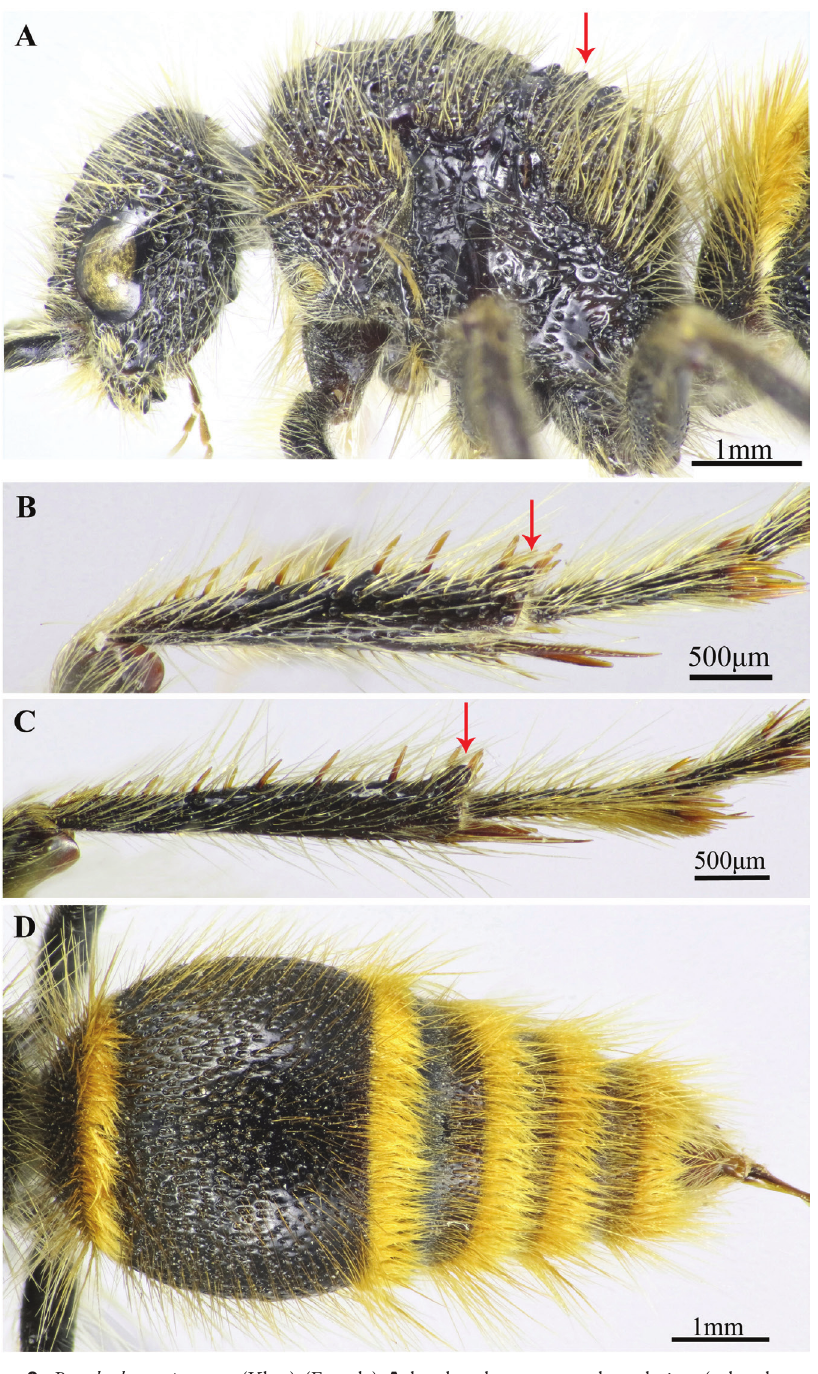
Figure 8. Pseudophotopsis aurea (Klug) (Female) A head and mesosoma, lateral view (tubercles on pro- podeal dorsum indicated) B, C mid and hind tibiae and basitarsomeres, respectively (prolongation at the apices of mid and hind tibiae indicated) D metasoma, dorsal